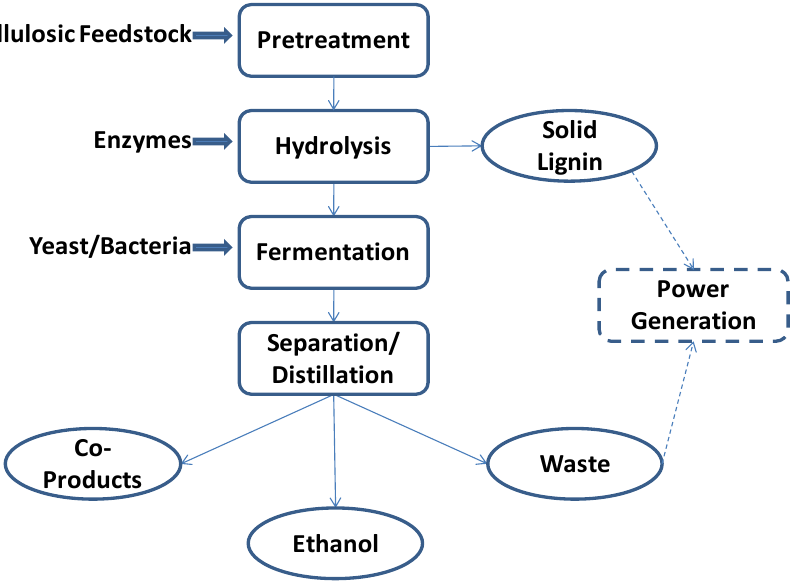
Figure 1. Biochemical conversion process to be placed